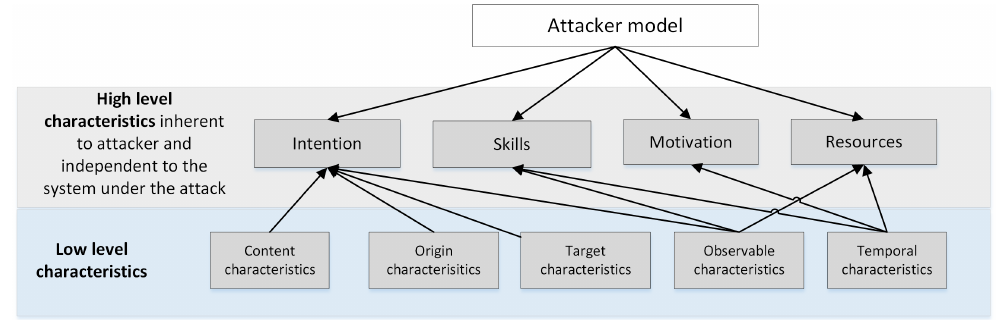
Figure 3. Overview of the links between high-level attributes and the related sets of low-level